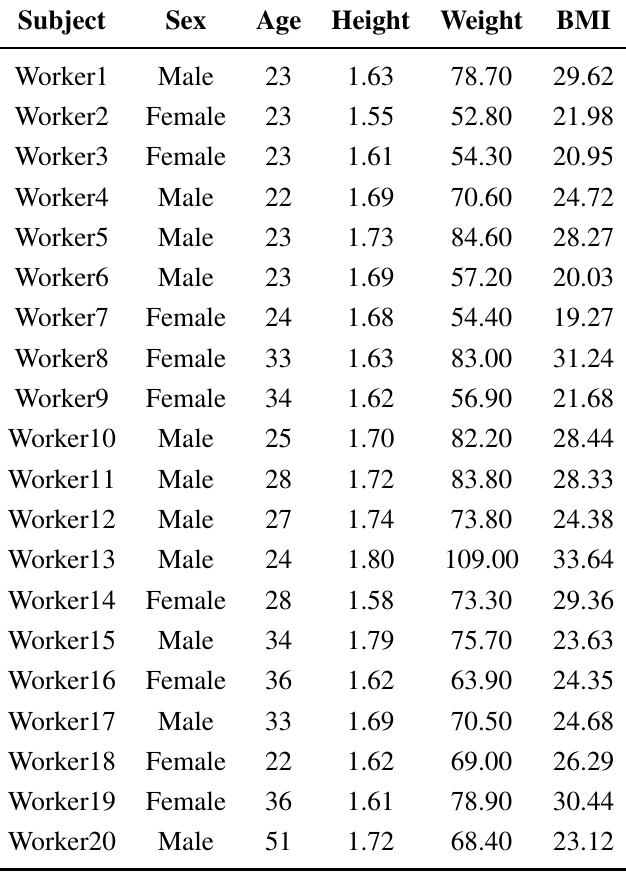
Table 6. Descriptive characteristics of the